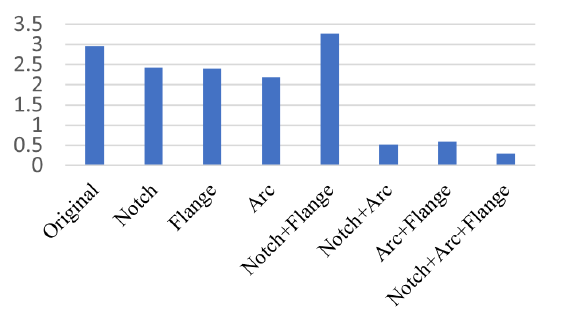
Figure 31. Torque ripples of different models.